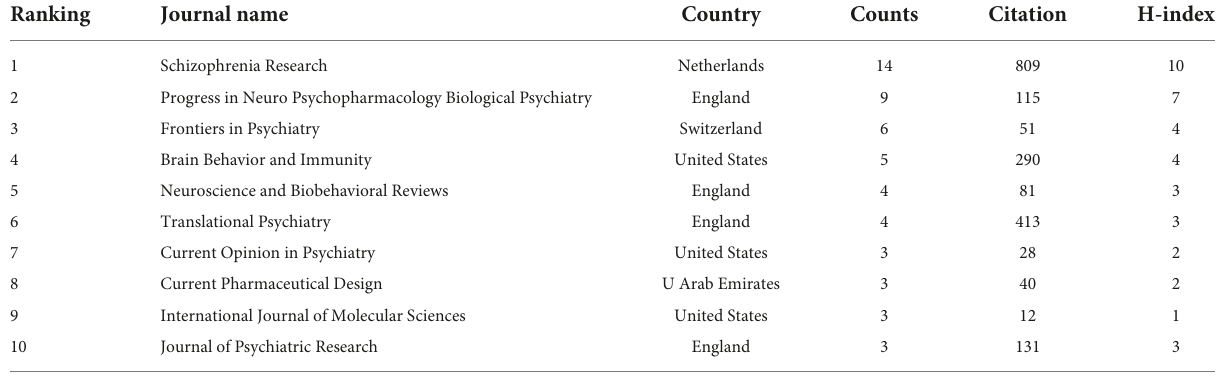
TABLE 2 Ranking of the top 10 journals based on publications.